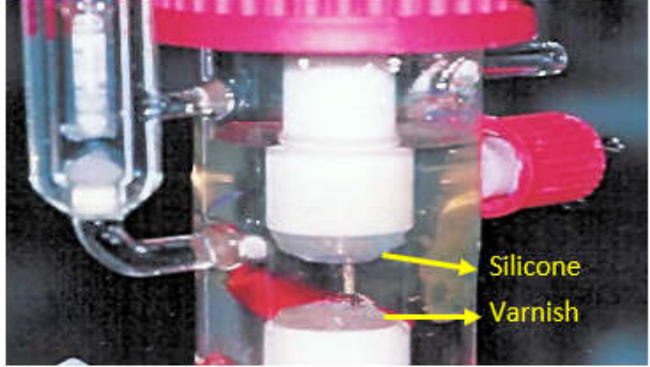
Figure 6. The electrochemical stress corrosion cell.